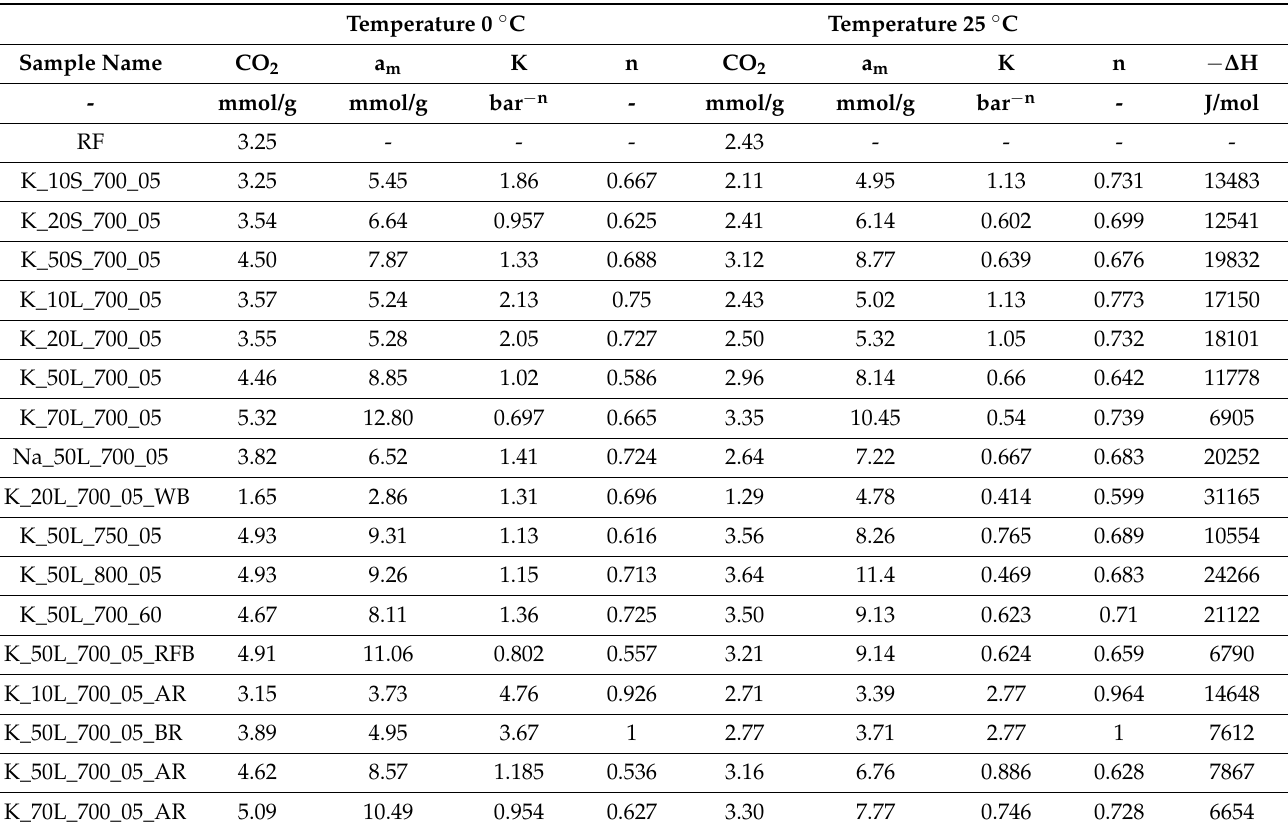
Table 2. Gas adsorption parameters determined based on Equation (1) and average adsorption heat determined based on Equation